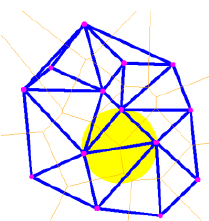
Figure24. Delaunay triangulation (in blue), Voronoi tessellation (in orange) and circumcircle (in yellow).